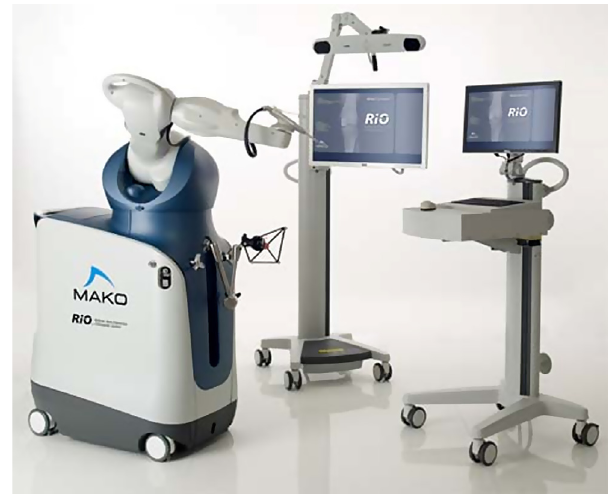
Figure 2. Mako Rio robot